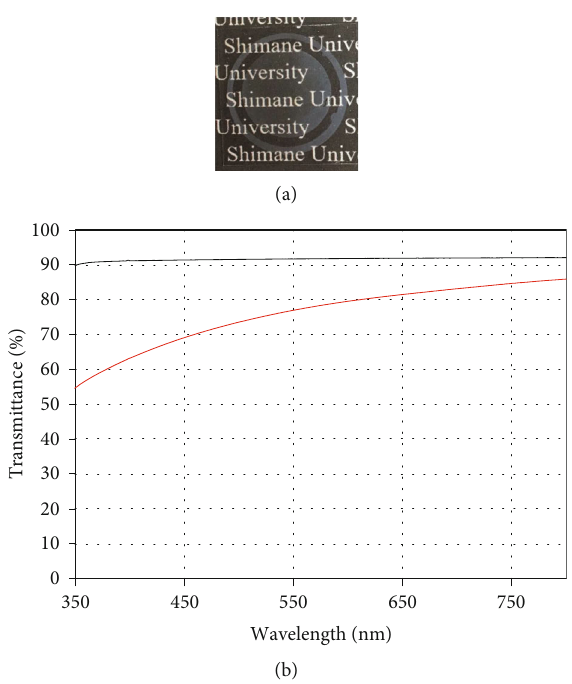
Figure 3: (a) Photograph of the LDH only fi lm, (b) transmittance spectra of the LDH only fi lm (red line), and glass substrate (black line).